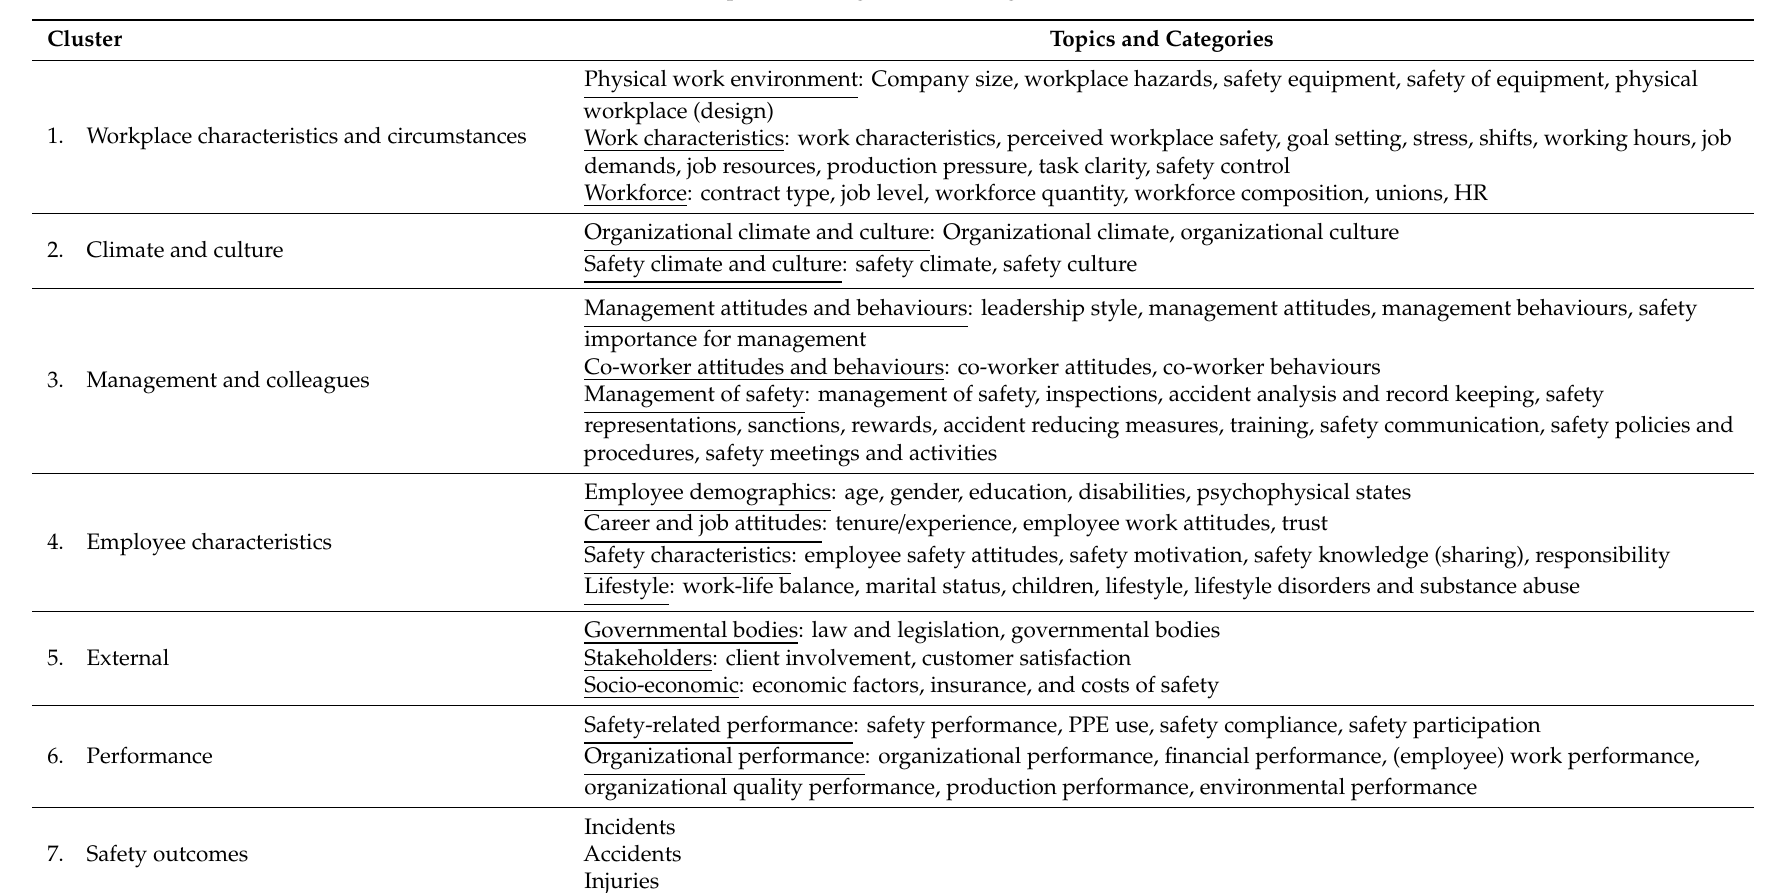
Table 1. Clusters, topics and categories according to Cornelissen et al.